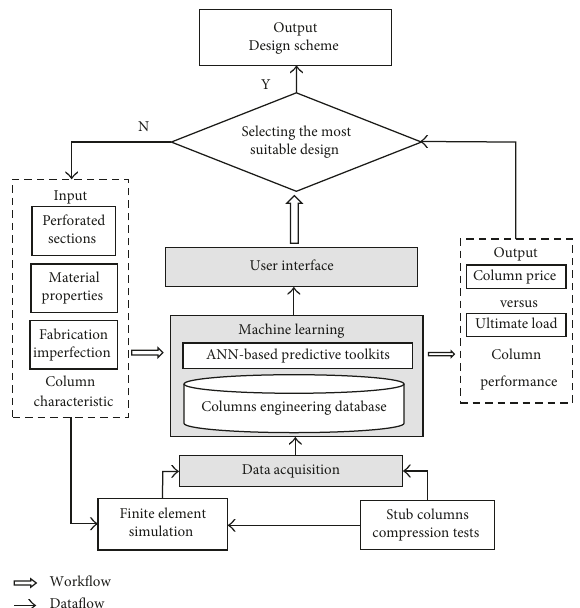
Figure 2: Framework of the proposed data-driven design decision based on prediction and optimization of